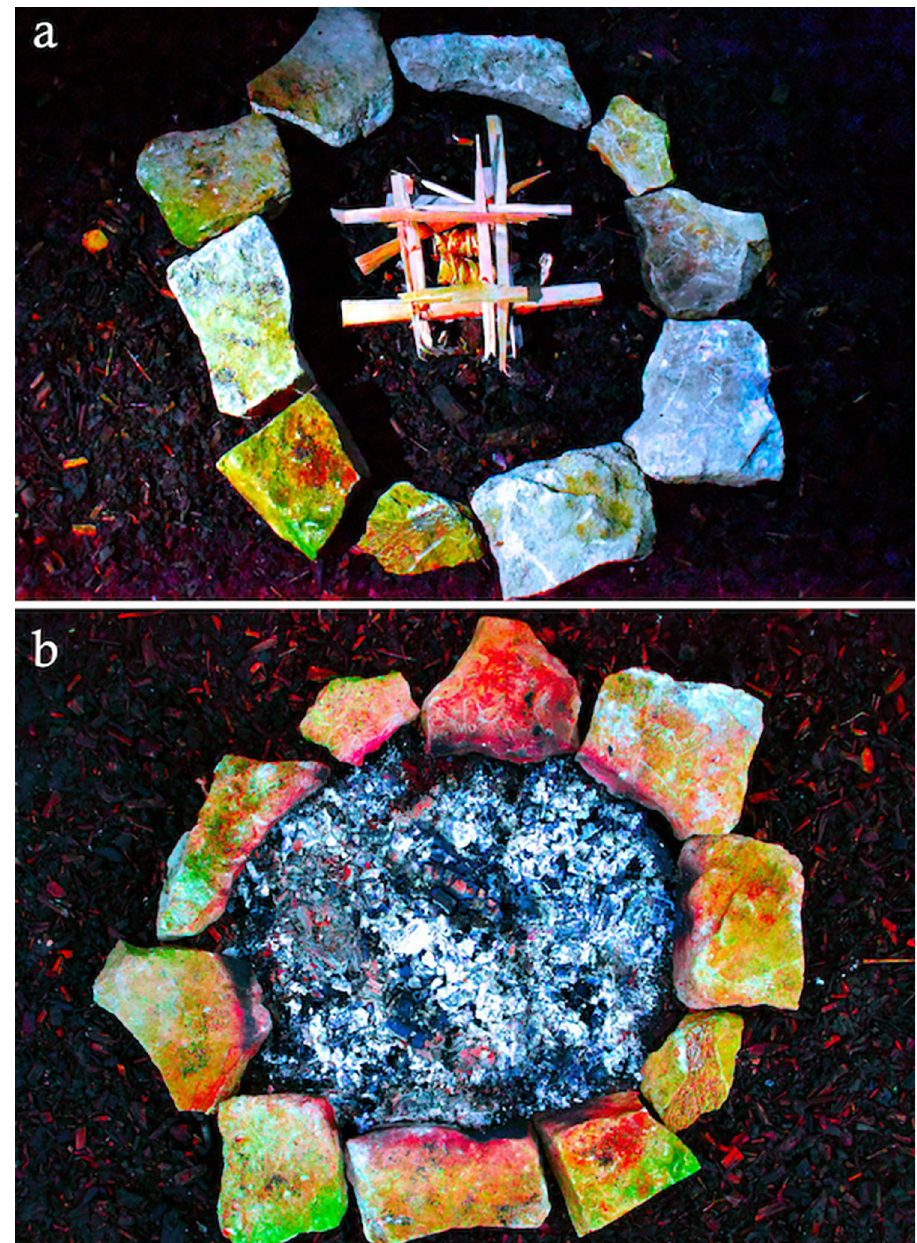
Fig 2. DStretch manipulated images in the LAB colourspace showing the difference between DStretch images of replica limestone plaquettes in experiment E (A) before heating and (B) after heating. Note that some reddish hues are visible in the DStretch image of replicas before heating, that may be caused by adhering sediment or the natural colouration of the limestone. Thus, the use of DStretch alone is not reliable to identify rubefaction